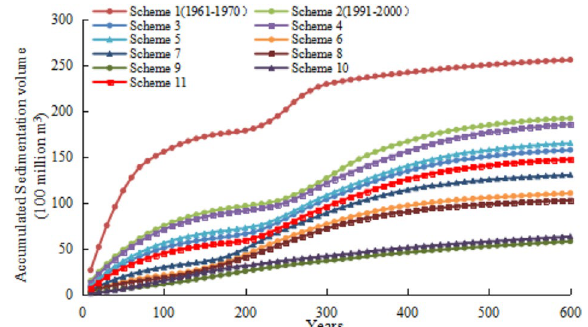
Figure 4. Accumulation process of the TGR under different calculation